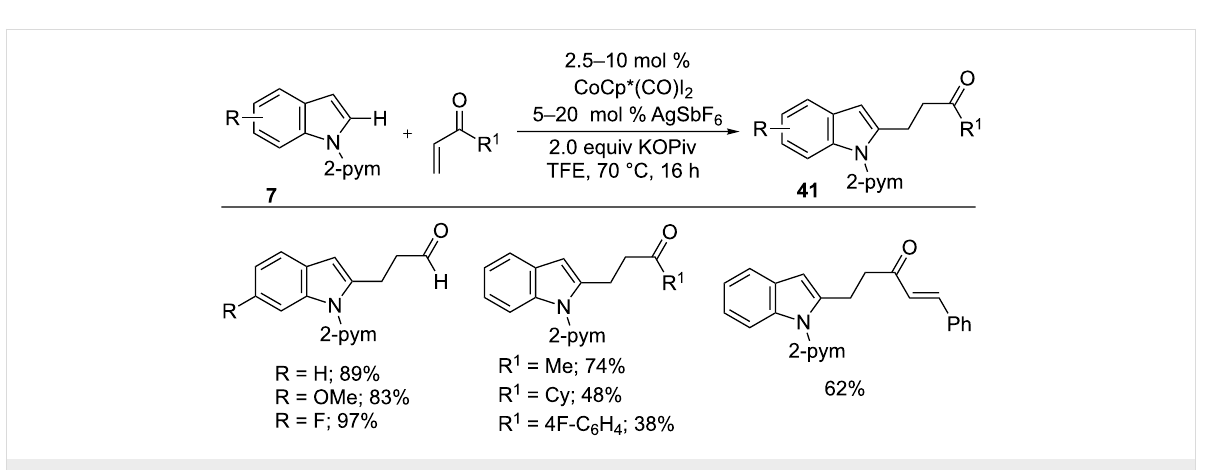
Scheme 27: Co(III)-catalyzed C2-alkylation of